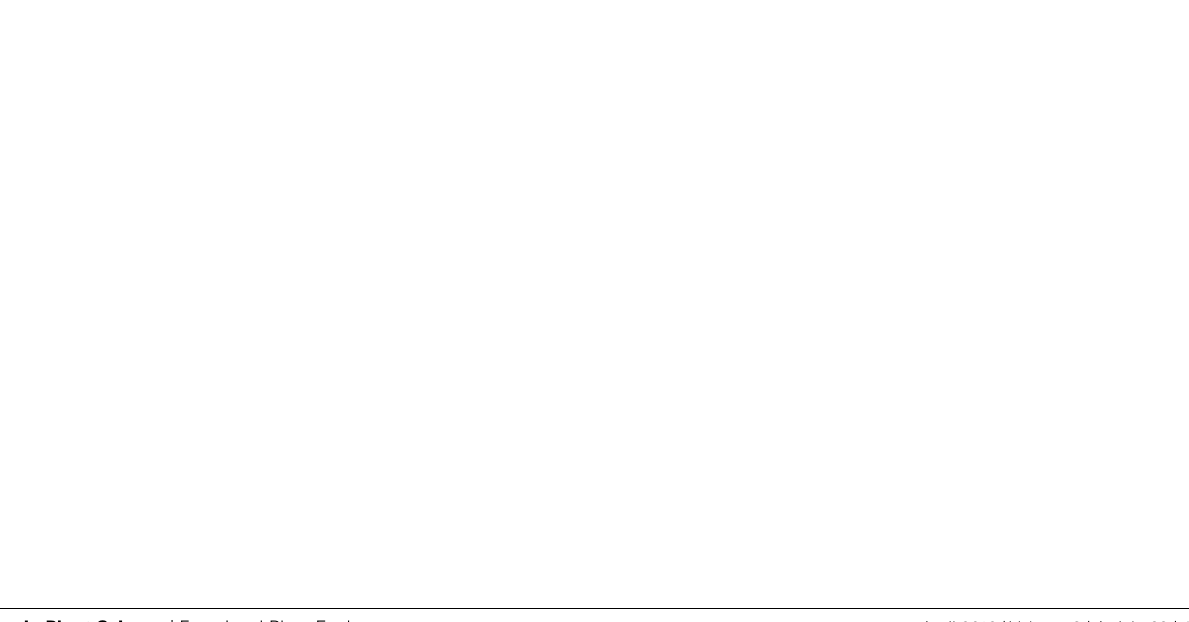
maximum temperature ( N = 5). For half full baskets, N = 3 for Betula branches and leaves, N = 6 for Empetrum and Hylocomium, N = 4 for Nephroma. Significant differences between full and half full baskets for one fuel type are denoted with asterisks ( t -test: - = not significant, * P < 0.05, ** P <